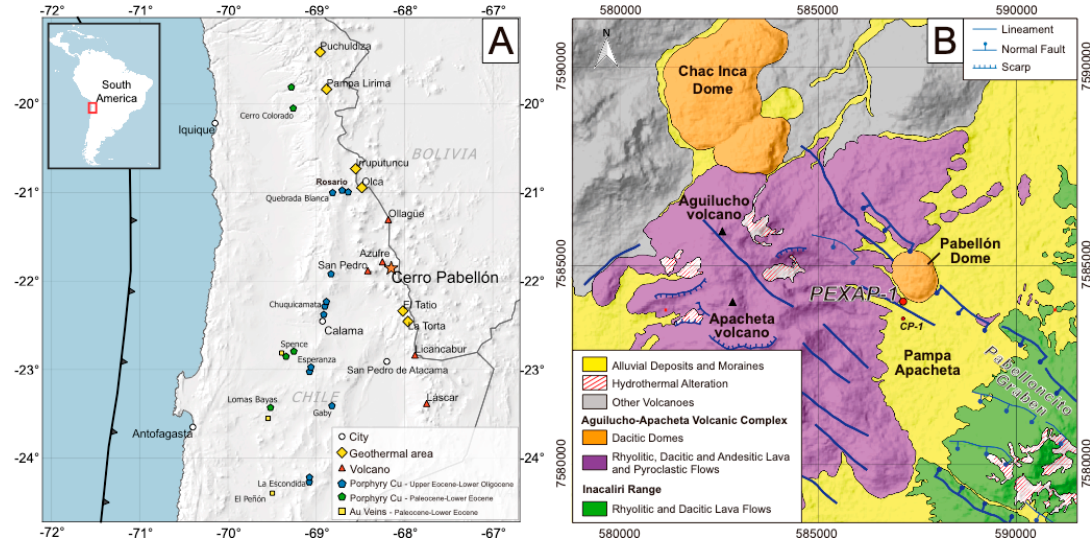
Figure 1. ( A ) Location of the Cerro Pabellón geothermal system in the Altiplano of northern Chile. ( B ) A geological map of Cerro Pabellón showing the location of the PEXAP-1 drill hole (red circle). Figures modified from [36,37].